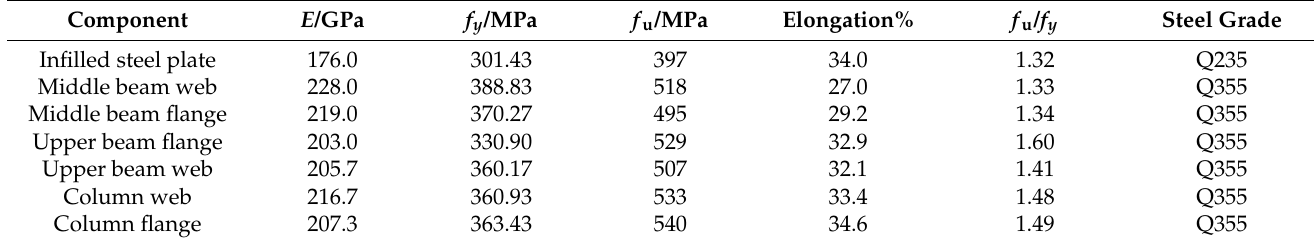
Table 2. Material properties [46].